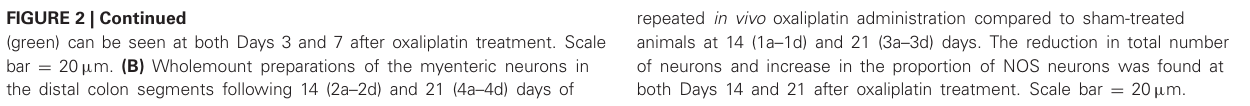
FIGURE 3 | Morphological changes in myenteric NOS-IR neurons following repeated intraperitoneal administration of oxaliplatin. Neurons from mice receiving oxaliplatin from Days 3 to 21 (C–F) display